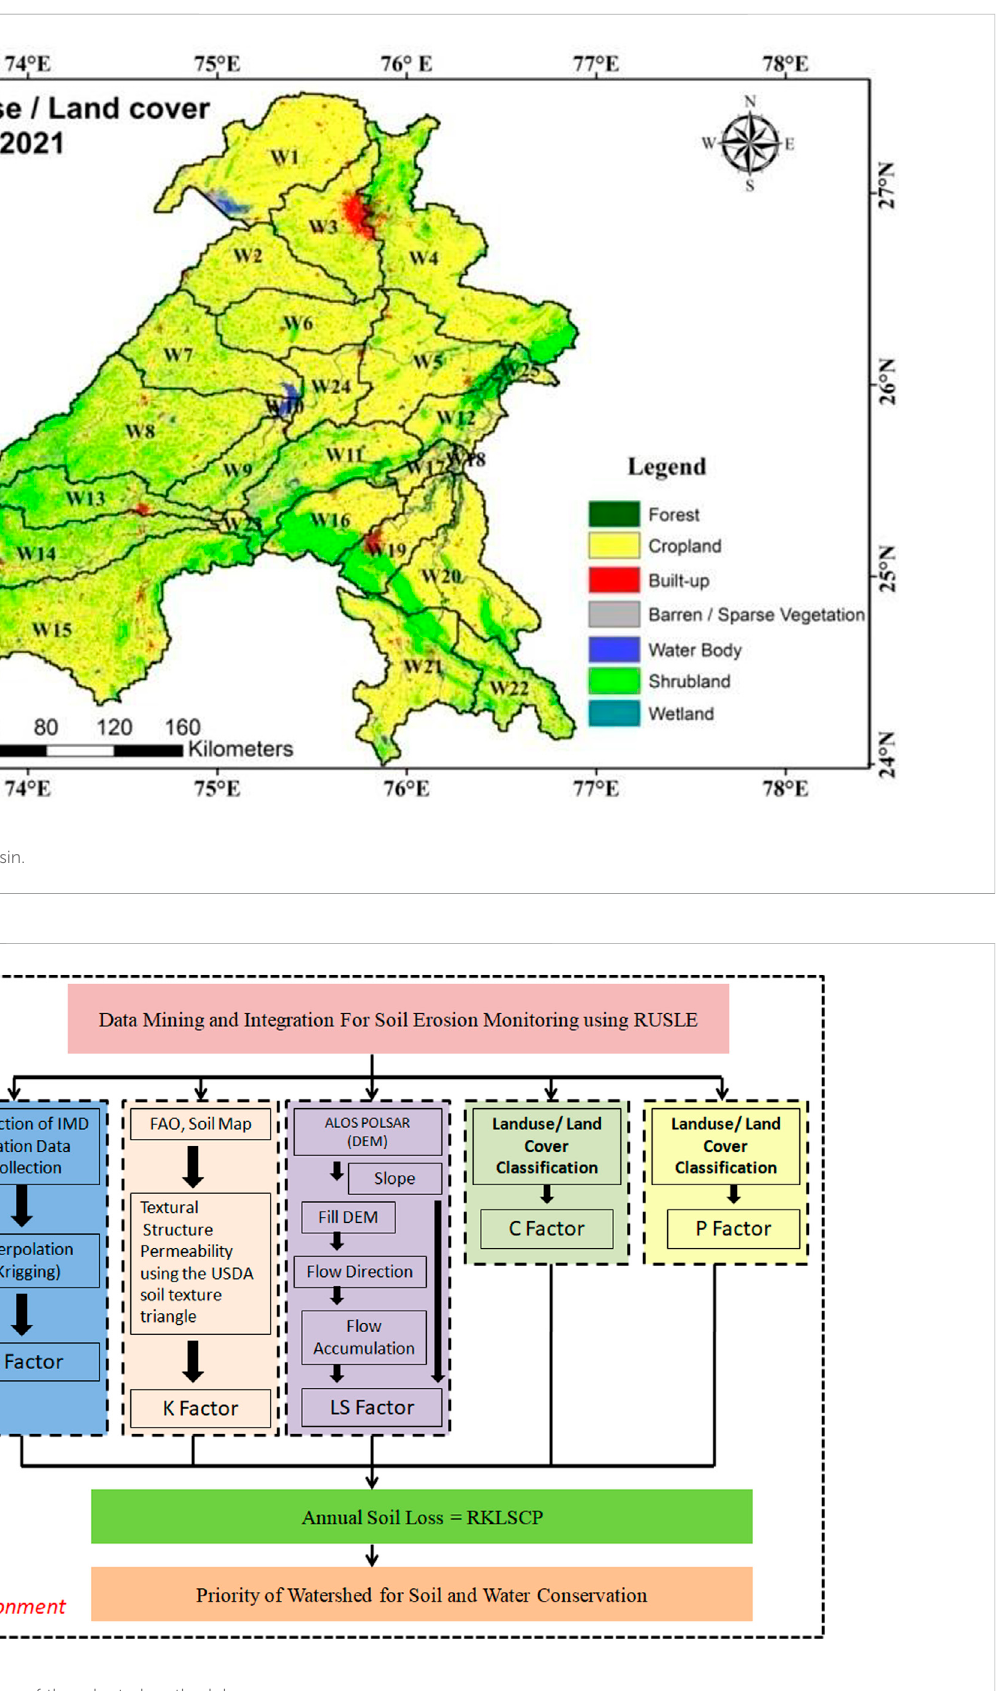
FIGURE 3 Complete work fl ow diagram of the adopted